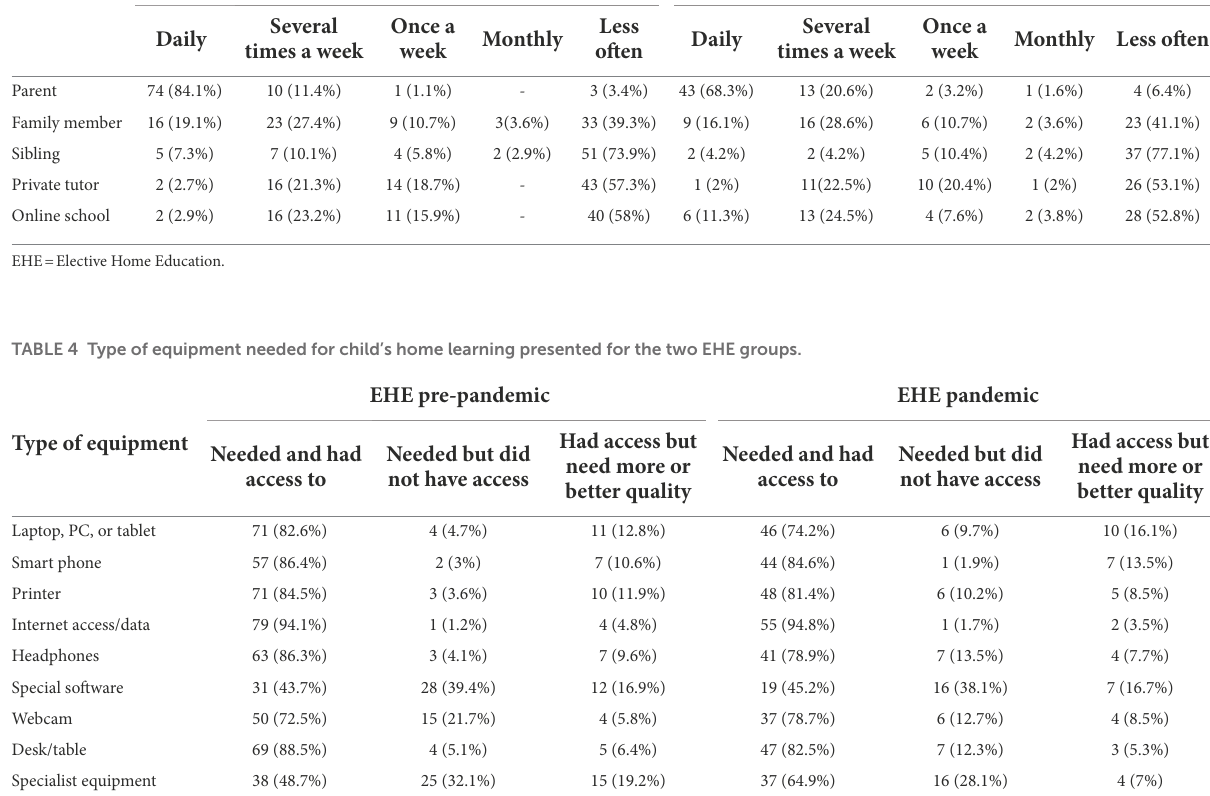
TABLE 3 Type and frequency of support provided for child’s learning at home presented for two EHE